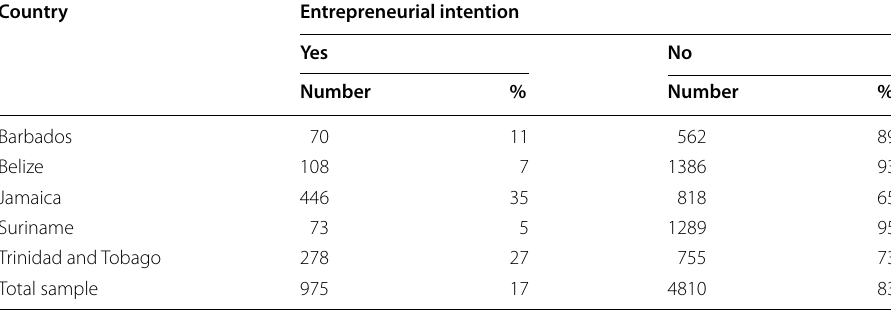
Table 3 Entrepreneurial intention